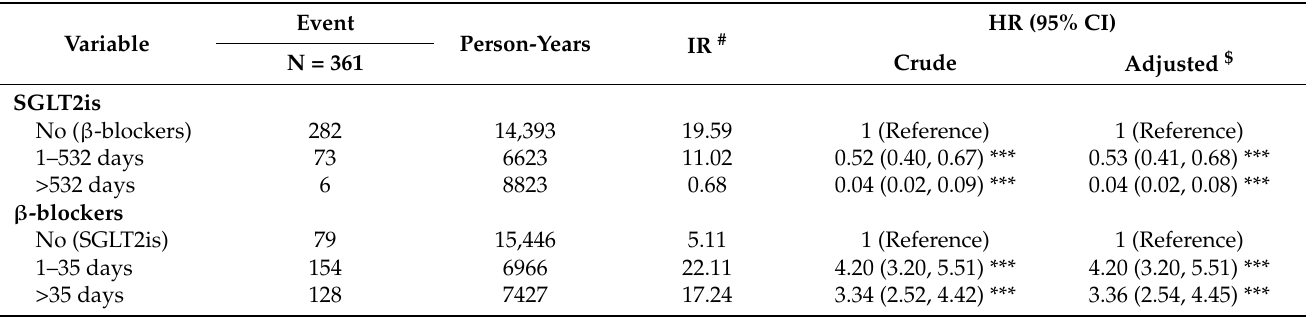
Table 3. Risk of HCC associated with different days’ supply of SGLT2is or β -blockers among DM patients with HBV/HCV.